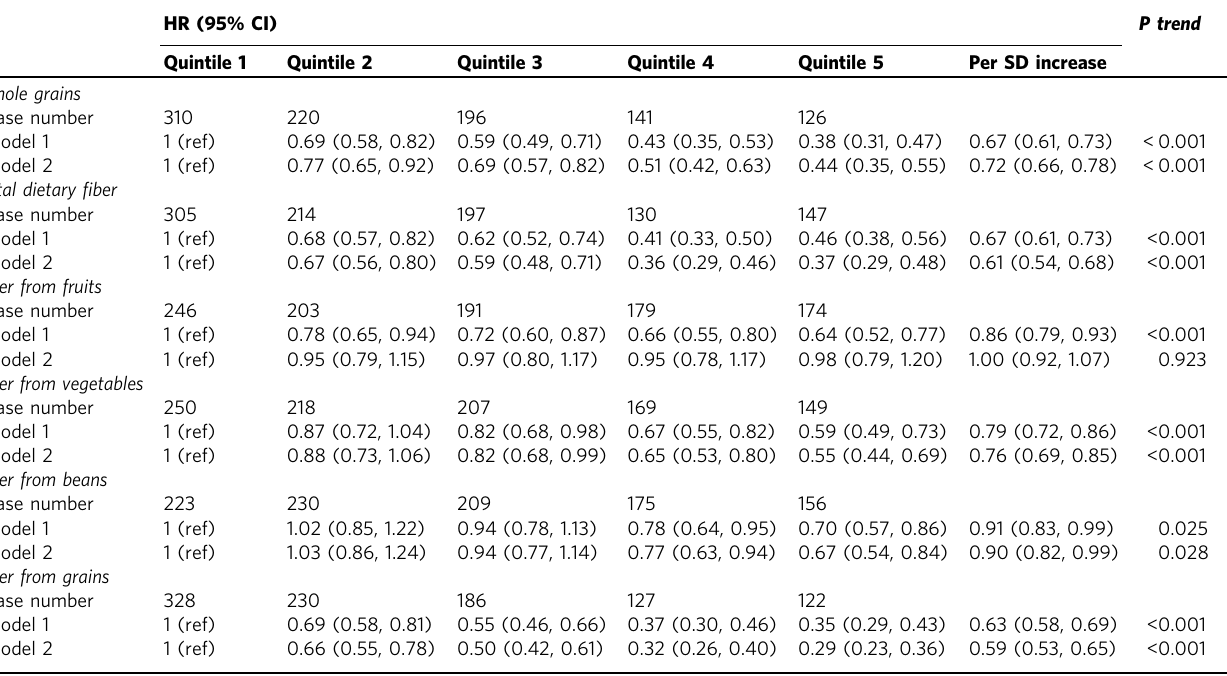
Table 3 The associations between whole grains and dietary fi ber intake with CLD mortality from the NIH – AARP Diet and Health